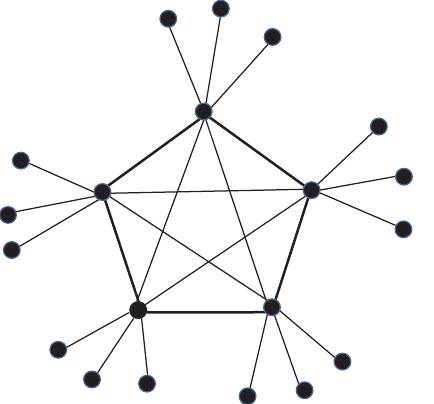
Figure 2: The communication topology 𝐾 5 ∘ 𝑃 3 .